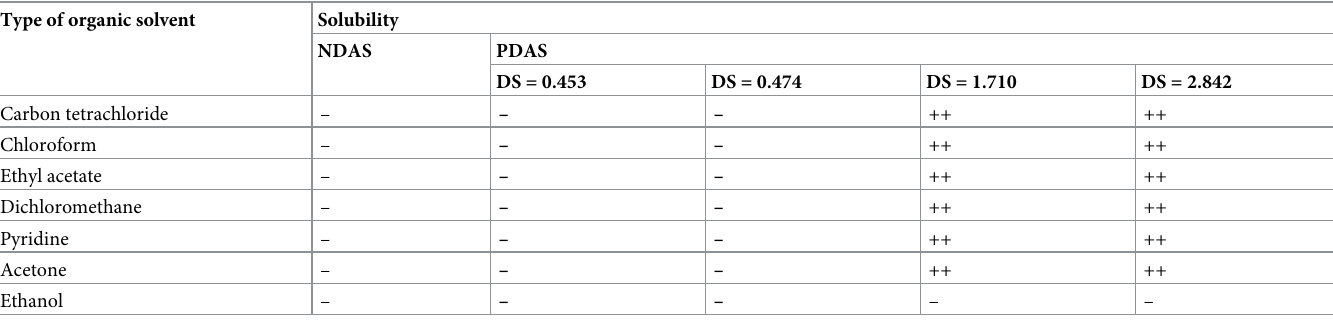
Table 5. Solubility of NDAS and PDASs with different DS (DS = 0.453, 0.474, 1.710, and 2.842) in organic solvents at 25˚C. Type of organic solvent